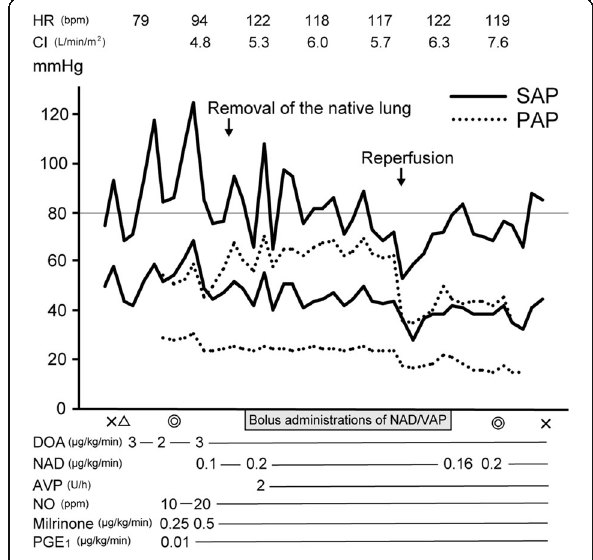
Fig. 1 Anesthetic chart. Double circle marks represent start/end of surgery; cross marks represent start/end of anesthesia; a triangle mark represents endtracheal